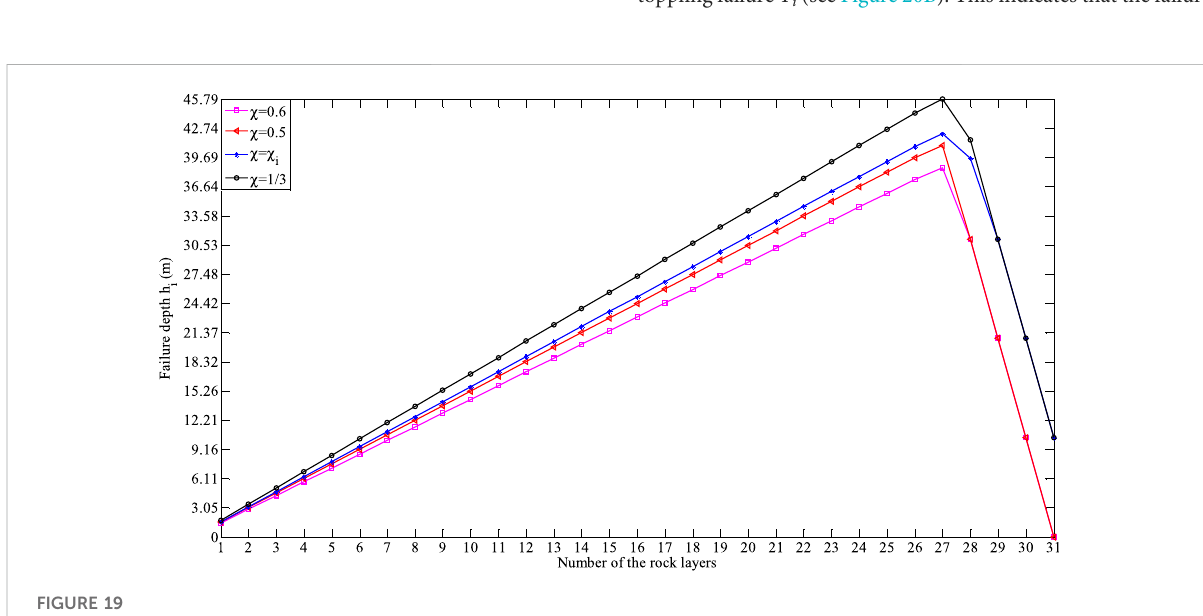
FIGURE 19 Failure depths of the rock layers h i obtained through the presented framework for different values of χ .